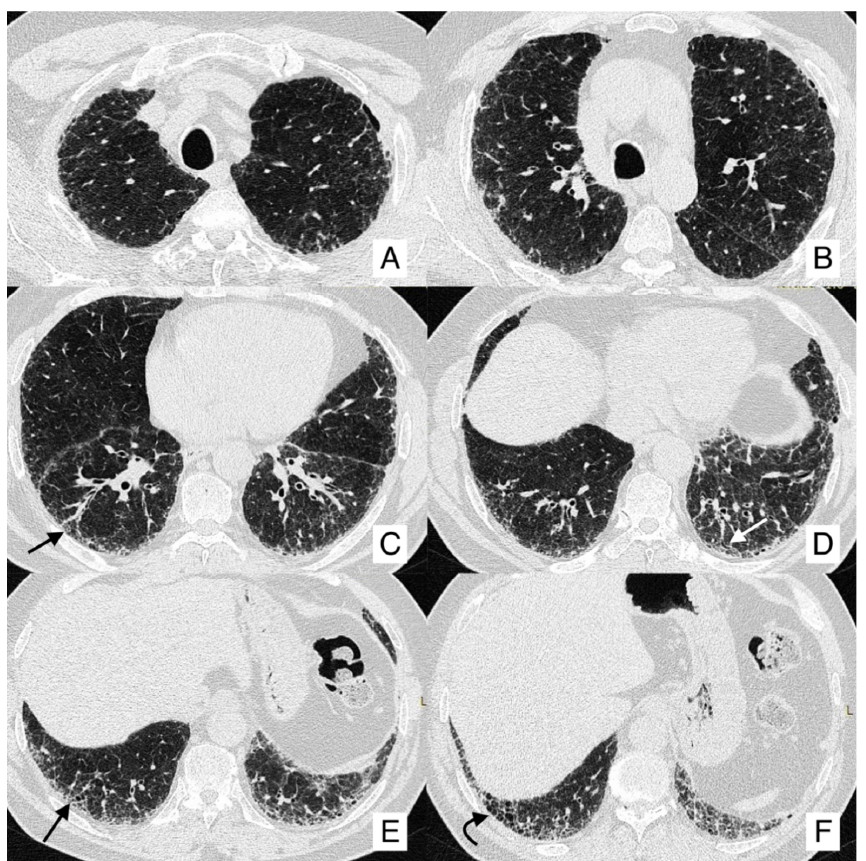
Figure 6. A patient with typical HRCT features of IPF. Images acquired at three different levels of the thorax ( A , B ) obtained above the carena; ( C , D ) scans obtained at middle levels of lungs; ( E , F ) acquired at basal regions. Reticulations are located in peripheral regions, more represented in the medium regions of the lung, and at the pulmonary basis (black arrows); there is a typical cranio-caudal gradient of these imaging findings. Cystic spaces are well-demonstrated (honeycomb area is clearly recognizable in the right costophrenic angle, black curved arrow in ( E ), reticulations and small bronchiectasis are well-appreciated (black arrows in ( C , E ), white arrow in ( D ). Therefore, a UIP pattern could be recognized.